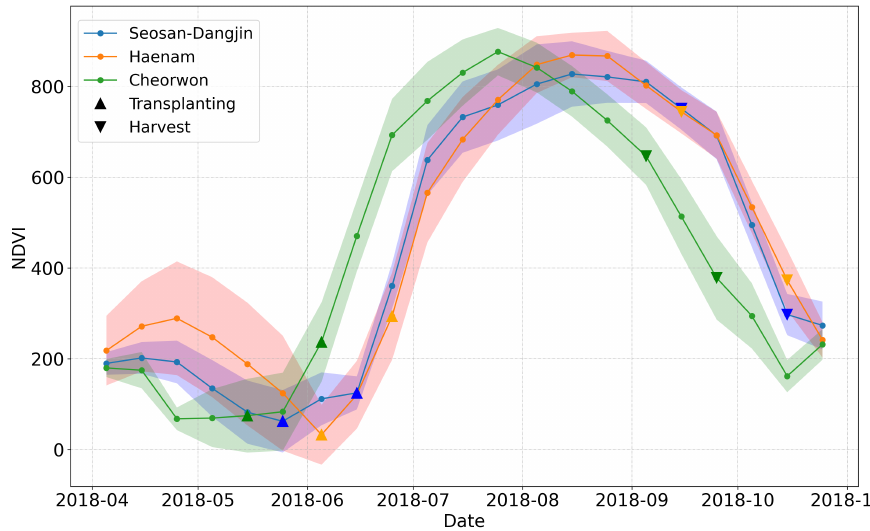
Figure 2. NDVI time-series for the three study sites; Seosan-Dangjin (Blue), Haenam (Orange), Cheorwon (Green). The up-pointing triangles enclose the transplanting period, while the down- pointing triangles enclose the harvesting